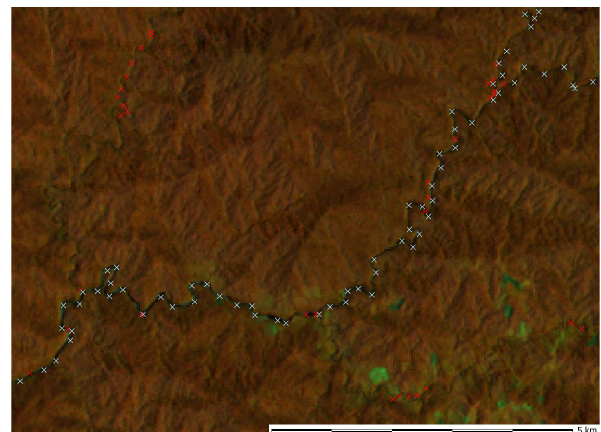
Fig. 3. Shaded relief of a Landsat false color composite (R,G,B = 4,5,3) overlaid with GPS reference points in red and points digitized from Landsat in